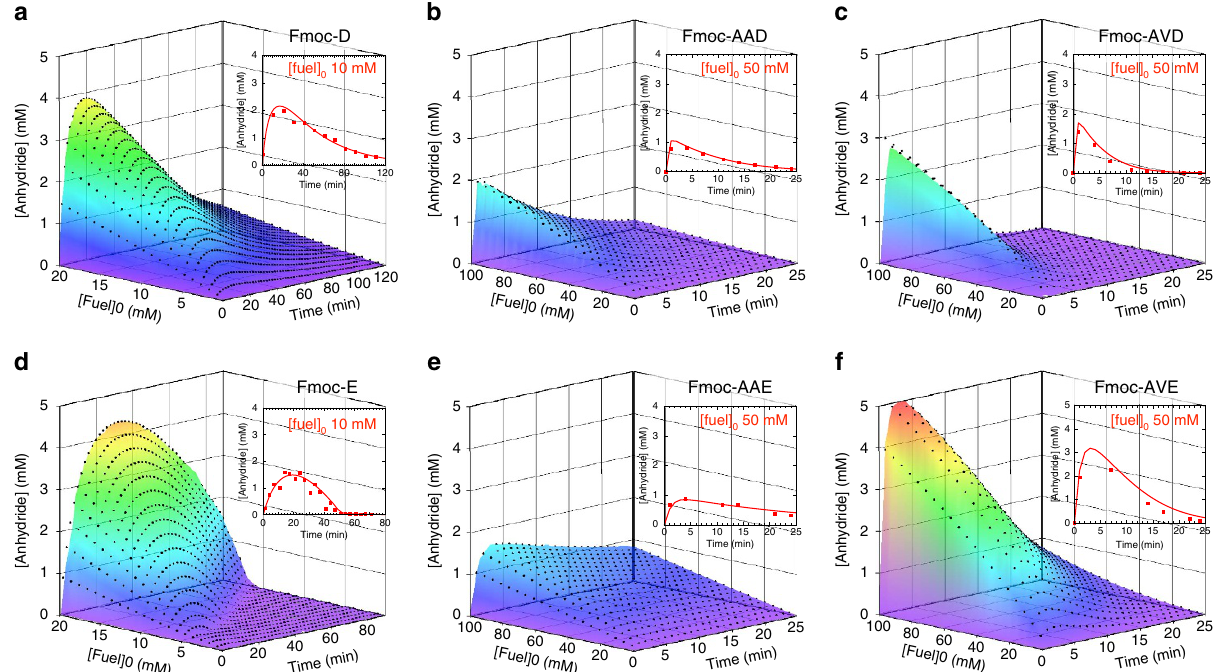
Figure 2 | Evolution of anhydride concentrations through fuel driven cycles calculated by kinetic models. ( a – f ) 3D plots of the anhydride concentration against time in a dissipative cycle for different initial EDC concentrations for Fmoc-D, Fmoc-AAD, Fmoc-AVD, Fmoc-E, Fmoc-AAE and Fmoc-AVE. The black markers represent the calculated concentration using the kinetic model, the planes represent interpolations between the model data. Note the different x (time) and y (fuel) axis for a , d compared to the Fmoc-AA and Fmoc-AV series. The insets show a 2D graph of the concentration anhydride against time for one batch of fuel (10 or 50mM) as determined by HPLC (markers) and the kinetic model (solid ranging from 3.8 (cid:2) 10 (cid:3) 2 s (cid:3) 1 for Fmoc-AVD to 3.8 (cid:2) 10 (cid:3) 4 s (cid:3) 1 (Fig. 3a). The turbid solutions turned transparent over time and a lack of assemblies was verified by confocal microscopy